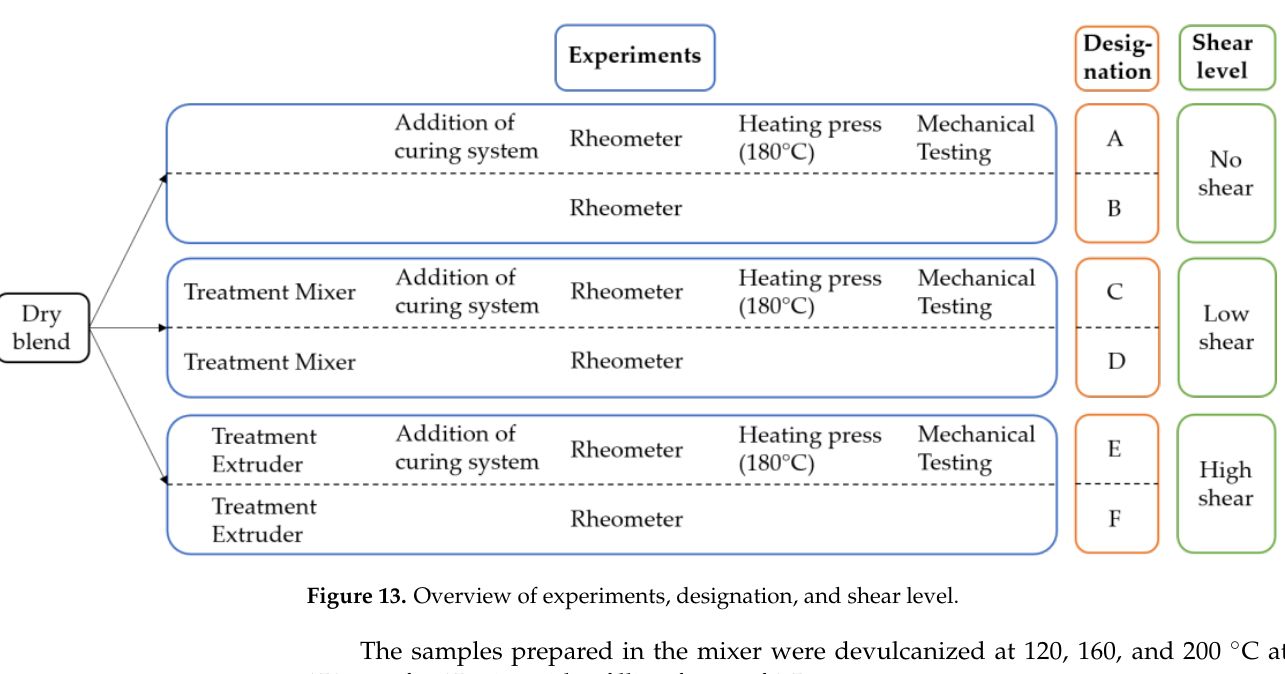
Figure 13. Overview of experiments, designation, and shear level.